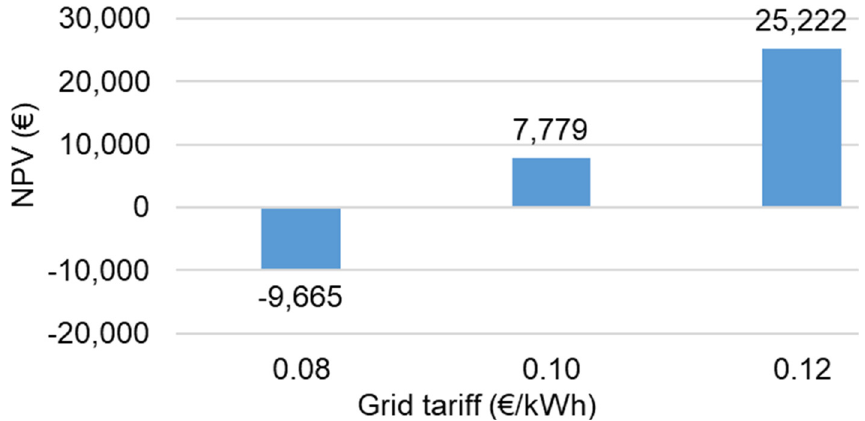
Figure 10. LCOE values under different discount rates and performance ratios.